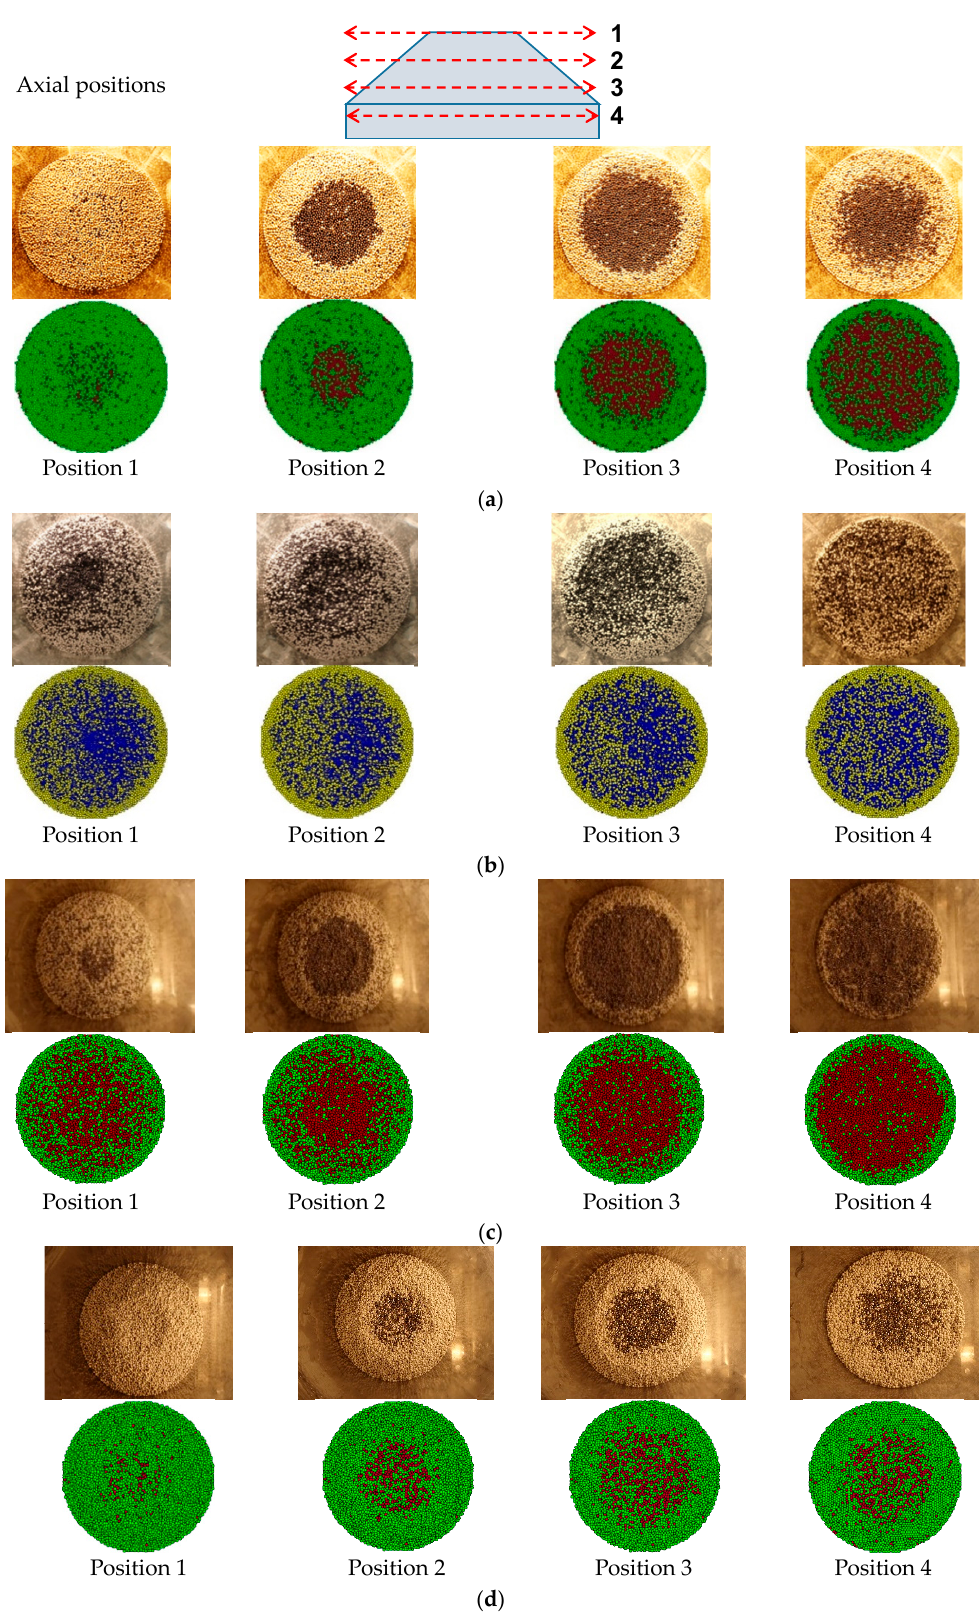
Figure 7. Top-view of mixed particle bed at four cross-sectional positions: ( a ) Case M1; ( b ) Case M2; ( c ) Case M4; ( d ) Case